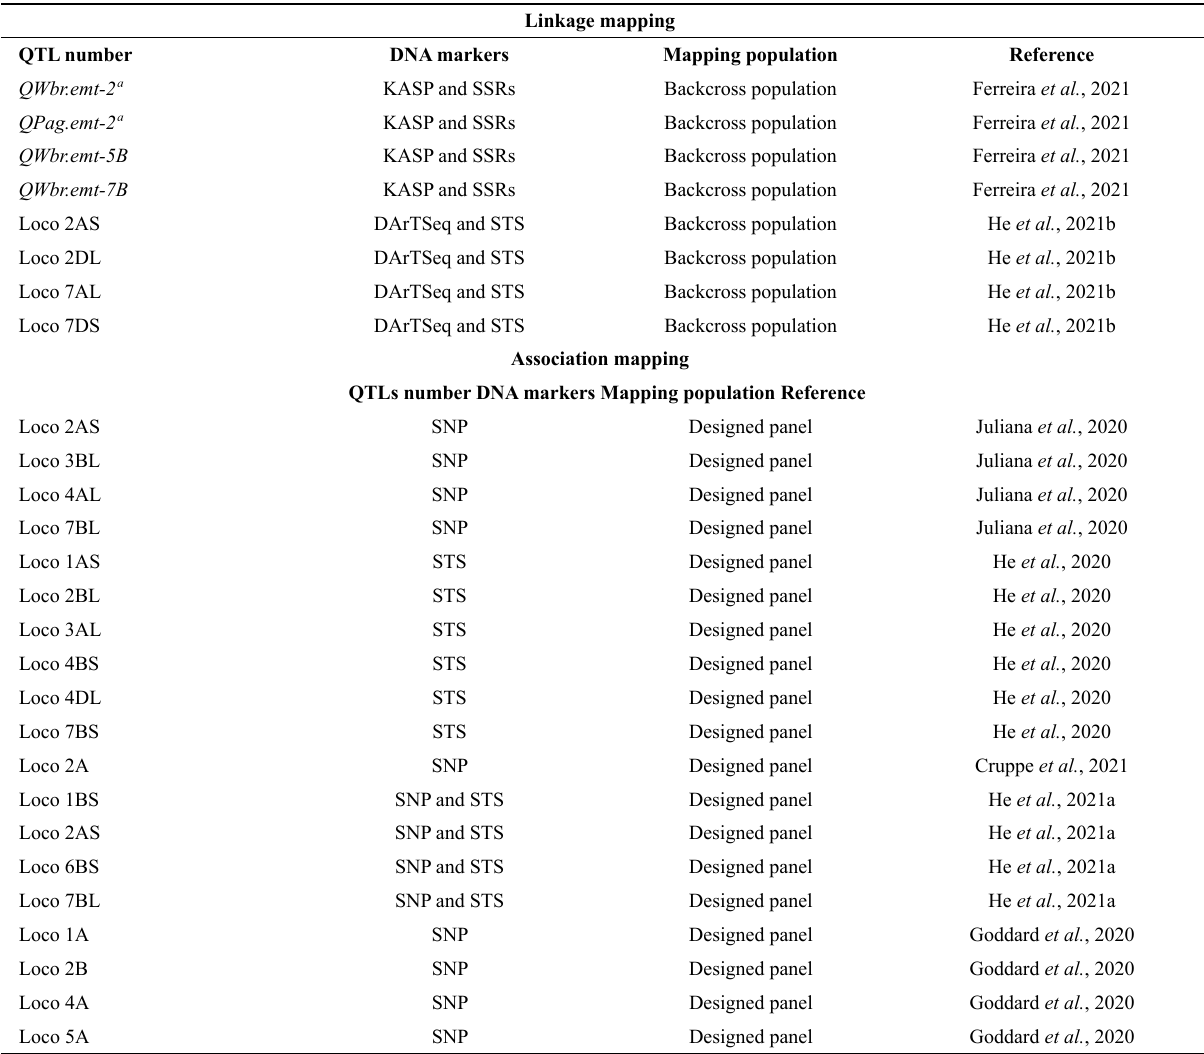
Table 2 - QTL studies in mapping for wheat blast